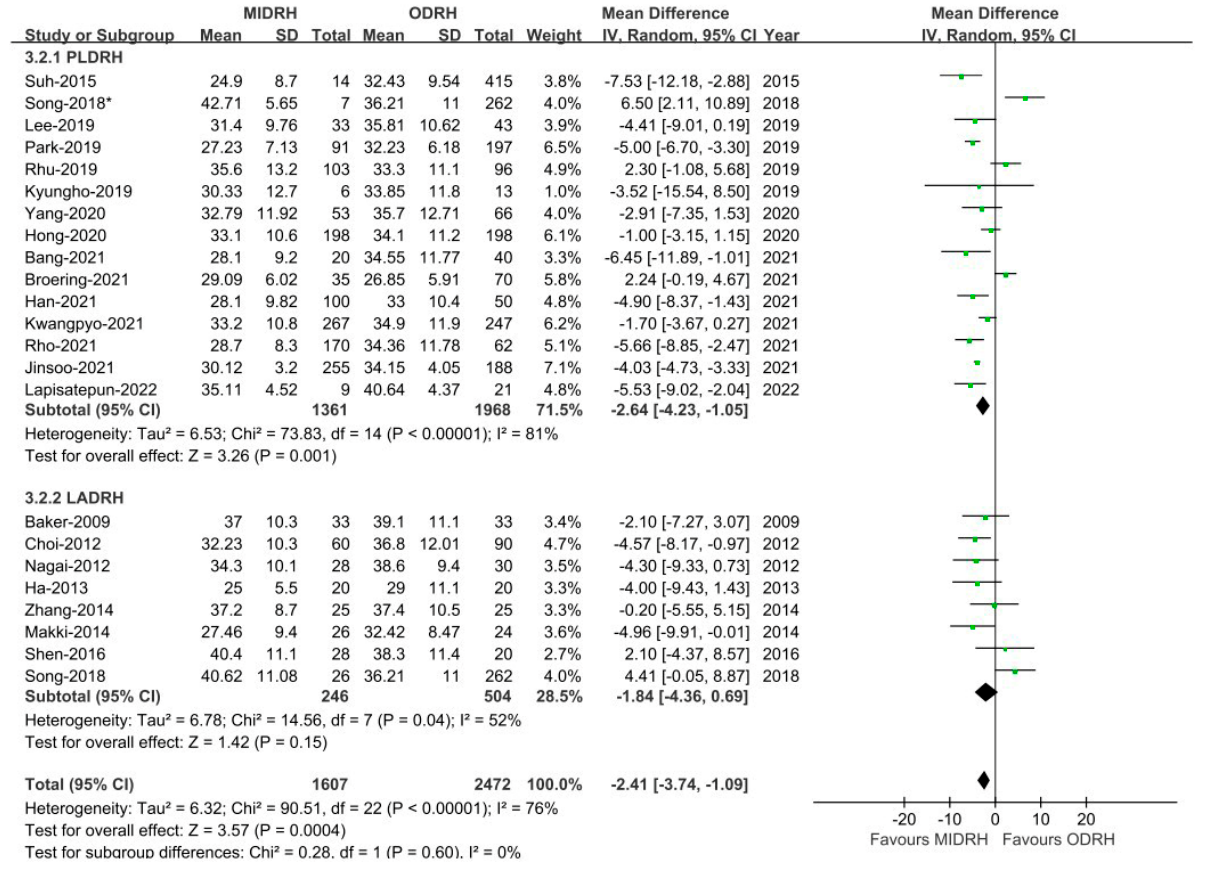
Figure 2. Forest plot of comparison of MIDRH versus ODRH for age [4–7,12–17,19–23,25–31]. *: Different data in the same